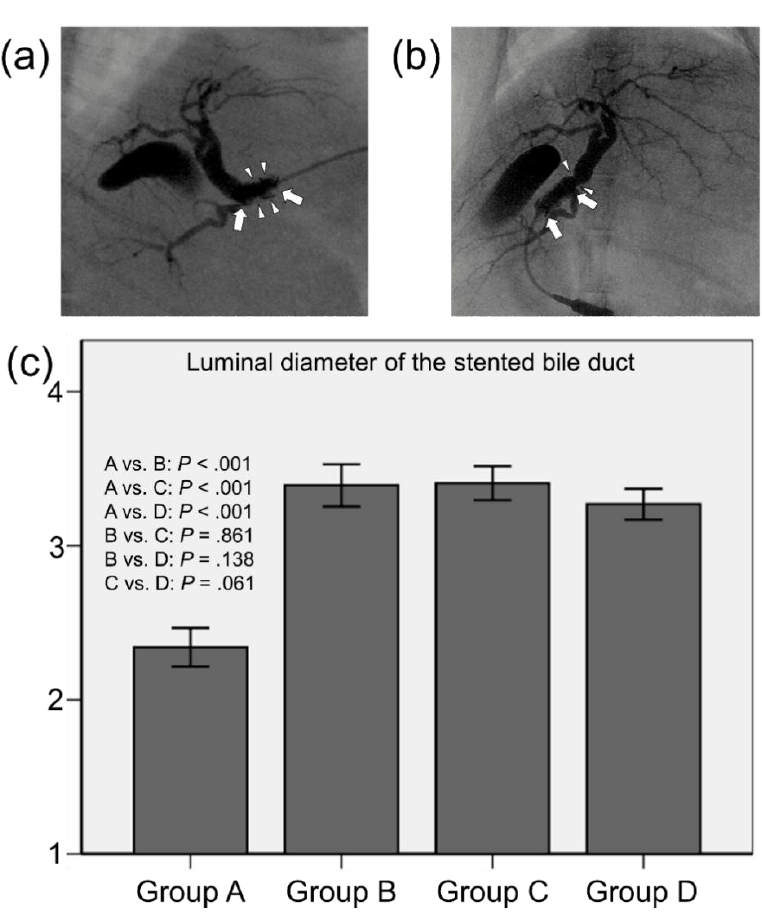
Figure 2. Representative cholangiographic images showing that SEMSs are fully expanded without stent migration. ( a ) Follow-up cholangiography in group A shows filling defects (arrowheads) in the stent lumen (arrows) caused by granulation tissue formation and biliary sludge. ( b ) Follow-up cholangiography showing relatively good patency of the stent (arrows) with no definite irregularities in group B. However, luminal narrowing (arrowheads) at the proximal end of the stent is observed. ( c ) Mean luminal diameter of the stented extrahepatic bile duct. Note: CI, confidence interval.